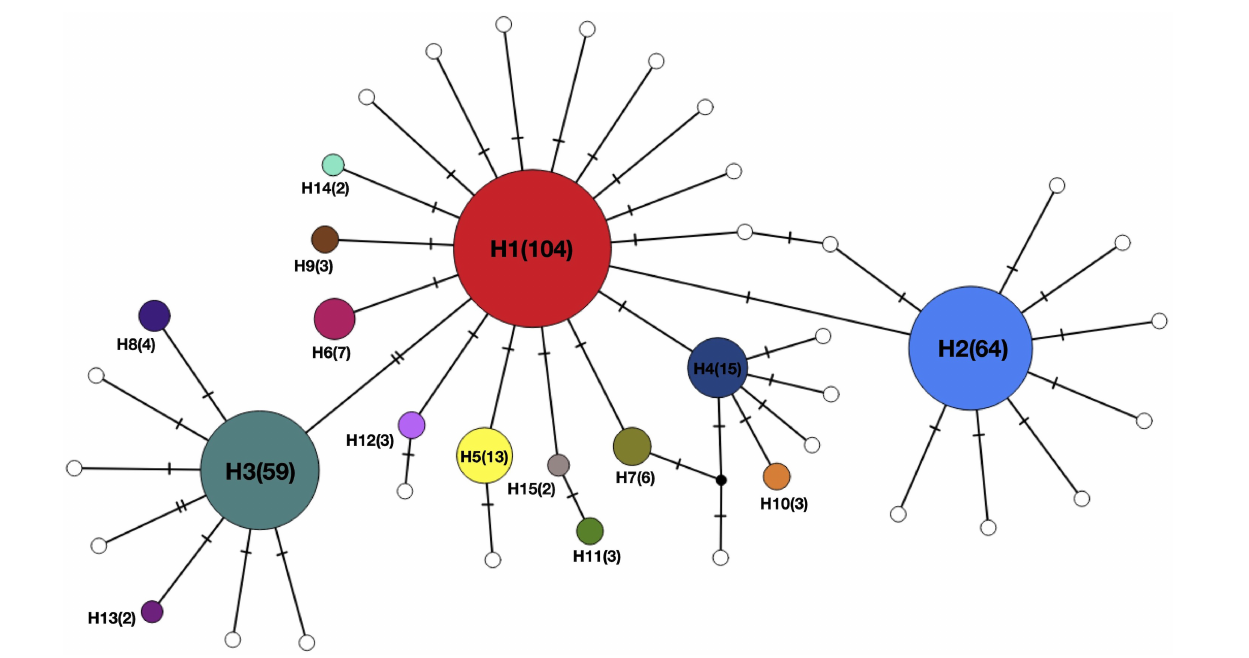
FIGURE 2 | Median-joining network of Eriphia ferox. Each circle represents a unique haplotype. Circle sizes are proportional to haplotype frequencies shown in parentheses. Each slash across a line connecting haplotypes indicates a single mutation step.